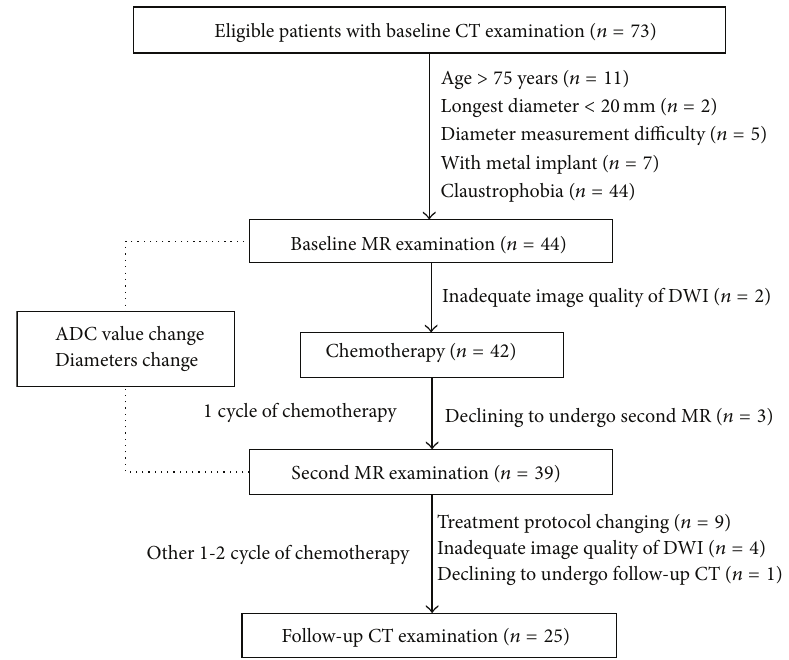
Figure 1: The patient selection and imaging flow chart. Baseline and follow-up CT are used for